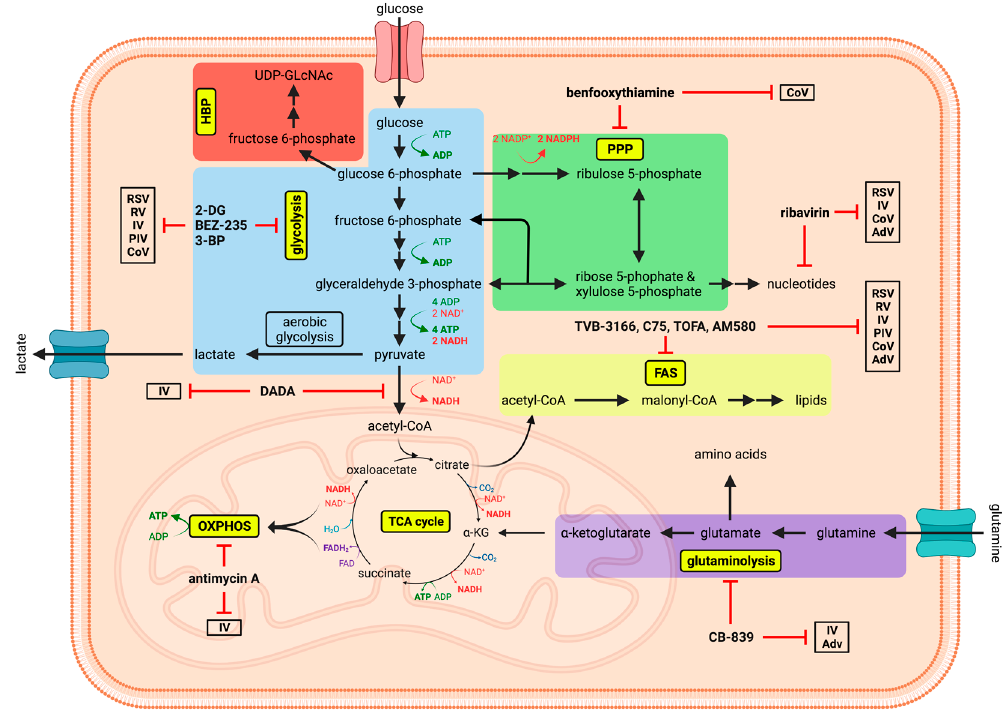
Figure 1. Schematic depiction of the main metabolic pathways, with potential compounds and their respective targets for antiviral metabolic interference. The graphic shows the dynamic network of some of the most important metabolic pathways (glycolysis, hexosamine biosynthetic pathway [HBP], pentose phosphate pathway [PPP], tricarboxylic acid [TCA] cycle, oxidative phosphorylation [OXPHOS], glutaminolysis and fatty acid synthesis [FAS]) in eukaryotic cells, which were shown to be altered and exploited during viral infections. Potential antiviral metabolic inhibitors are indicated along with those respiratory viruses they have been demonstrated to inhibit. Created with BioRender.com.